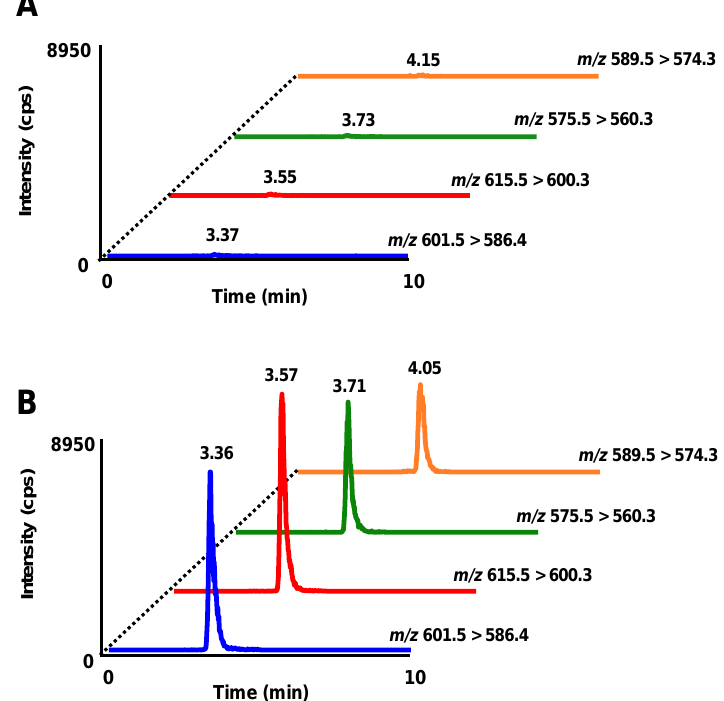
Figure 2. Typical multiple reaction monitoring (MRM) chromatograms analyzing OZ molecular species in plasma before ( A ) and 9 h after rice bran OZ (RBOZ) administration ( B ). Each MRM pair represents analysis of the following OZ molecular species: m / z 601.5 > 586.4, cycloartenyl ferulate; m / z 615.5 > 600.3, 24-methylenecycloartanyl ferulate; m / z 575.5 > 560.3, campesteryl ferulate; m / z 589.5 > 574.3, β -sitosteryl